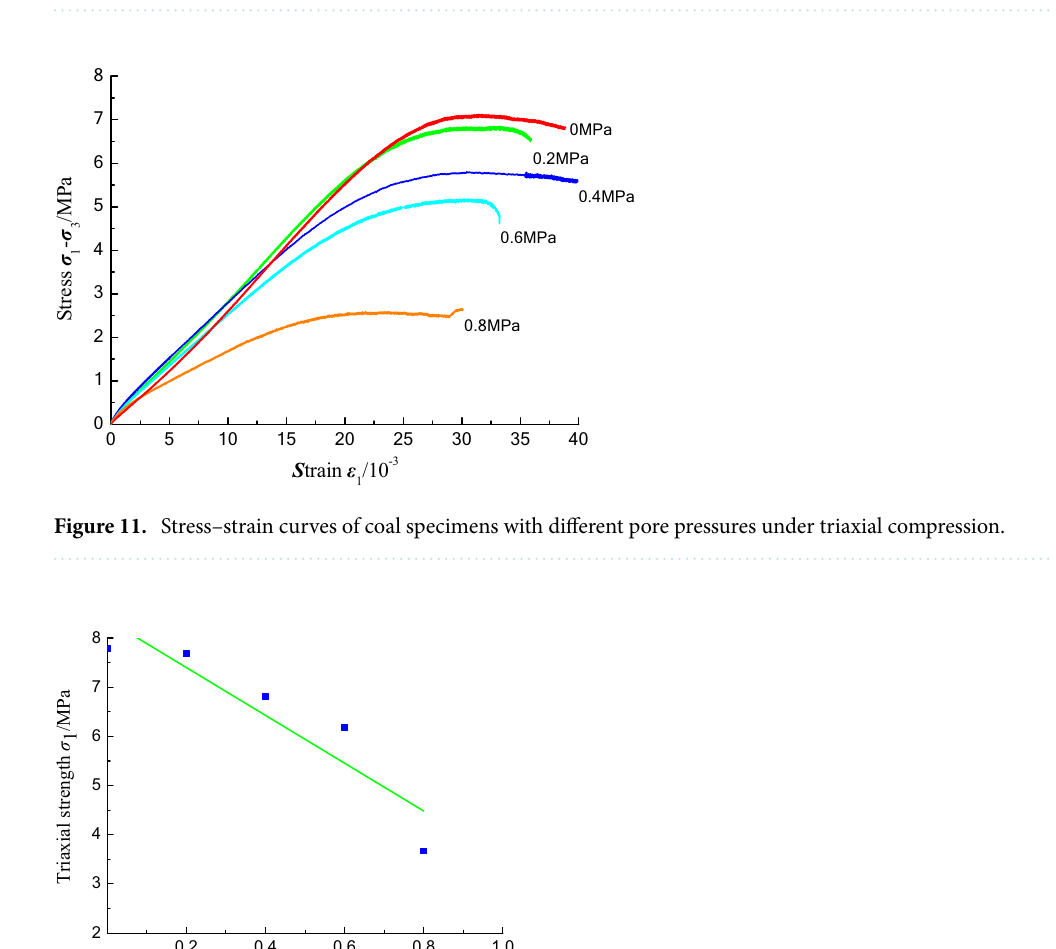
Table 2. Experimental results of triaxial compression tests on coal briquette specimens under different pore pressures.